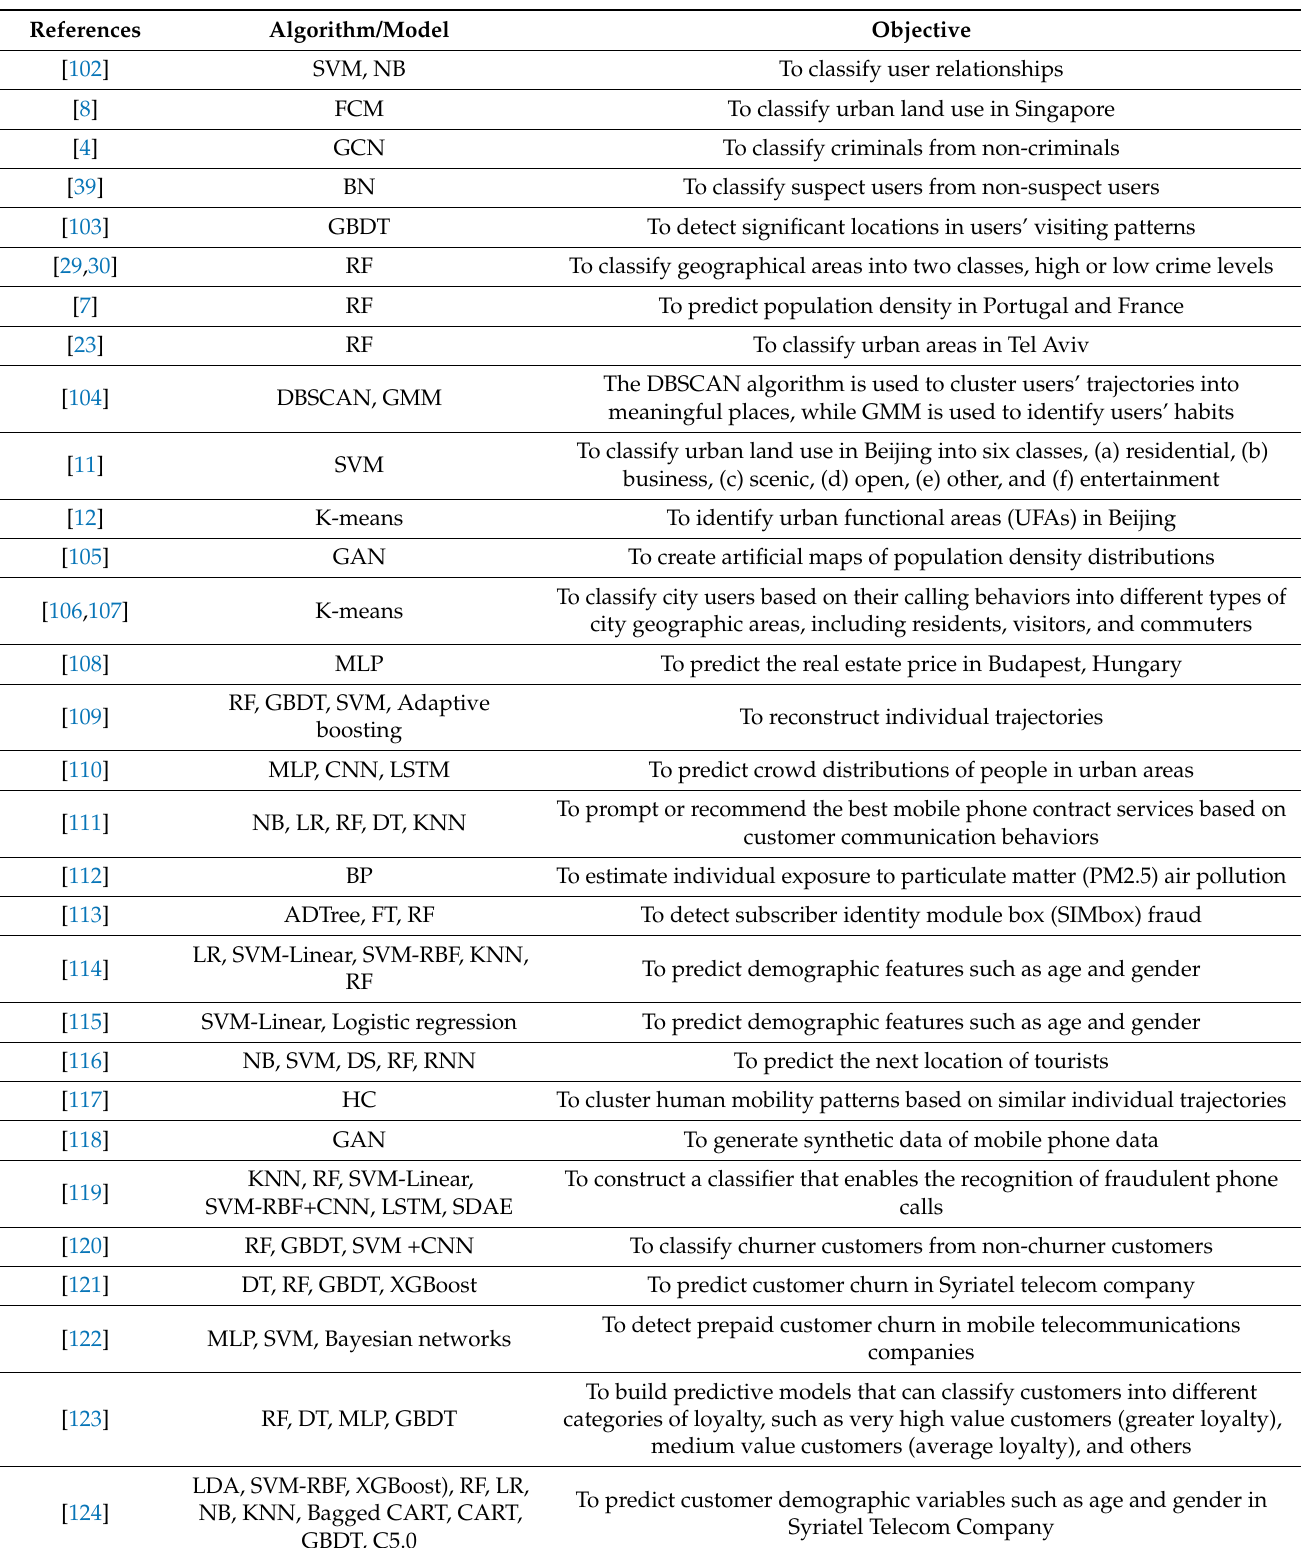
Table 7. Machine learning (ML) and deep learning (DL) models and algorithms used by previous researchers in mobile phone data studies. The abbreviation of algorithms is shown in the back